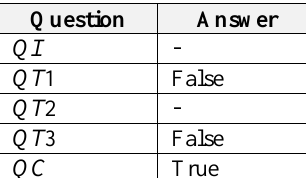
Table 5. Guiding questions and answers (1)